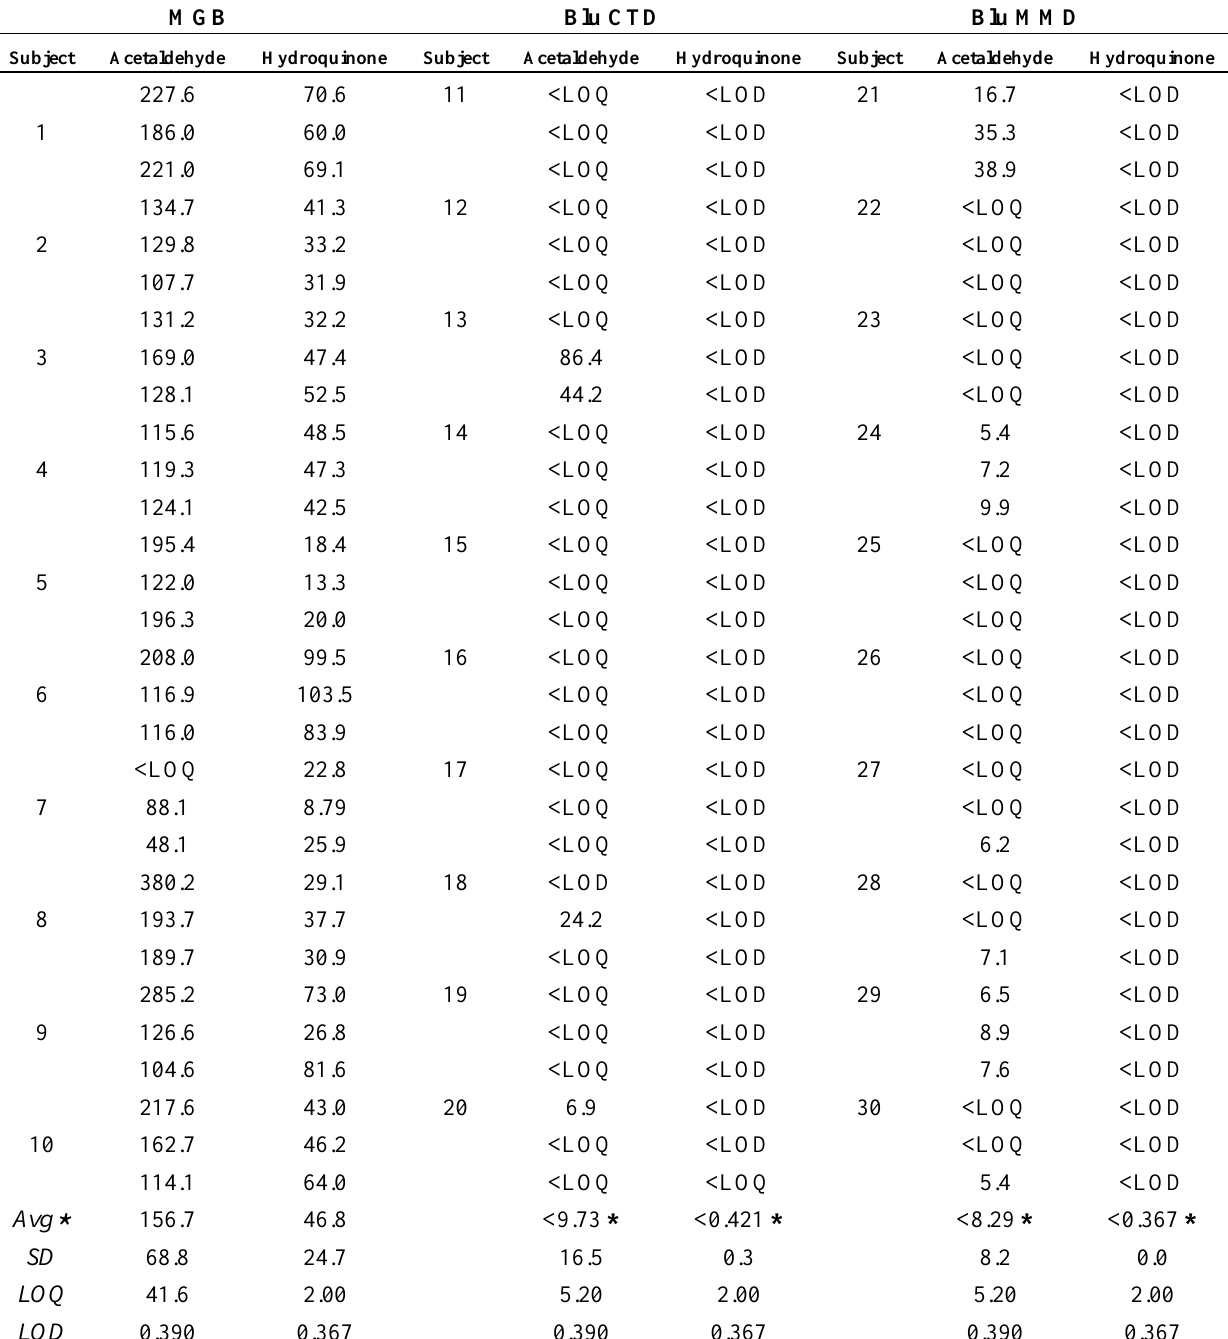
Note: * LOD and LOQ values were averaged to provide upper limit estimates in exhalates from the two e-cigarette